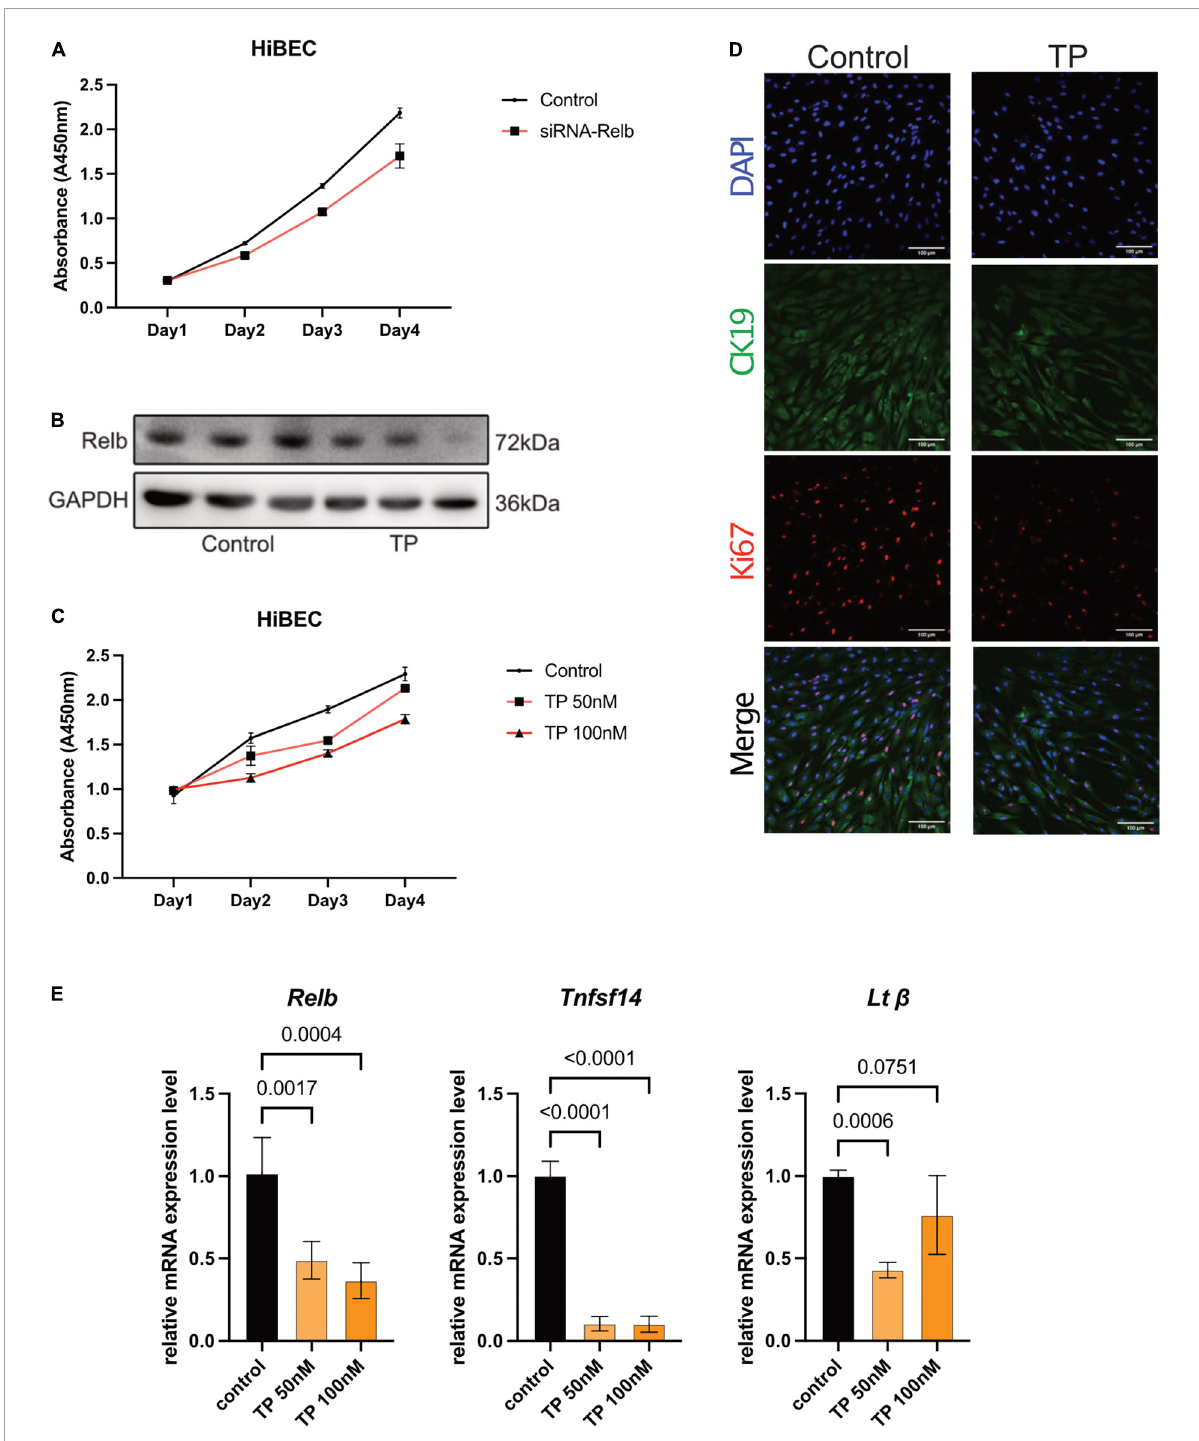
FIGURE2 Triptolide inhibits proliferation and RelB expression in HiBEC. (A) The growth curve of HiBEC after transfection of siRNA- Relb . (B) The protein level of RelB in HiBEC after TP treatment. (C) The growth curve of HiBEC after TP treatment. (D) Double immunofluorescence staining for CK19 (green) and Ki67 (red) from HiBEC after TP treatment. Nuclei were counter-stained with DAPI (blue). (E) Relb , Tnfsf14 and Lt β mRNA was measured in HiBEC after TP treatment. Data are shown as the mean ± SD. Data represent at least 3 independent experiments with triplicate measurements. Analysis of variance (one-way ANOVA) was used. p values represents significance different from control